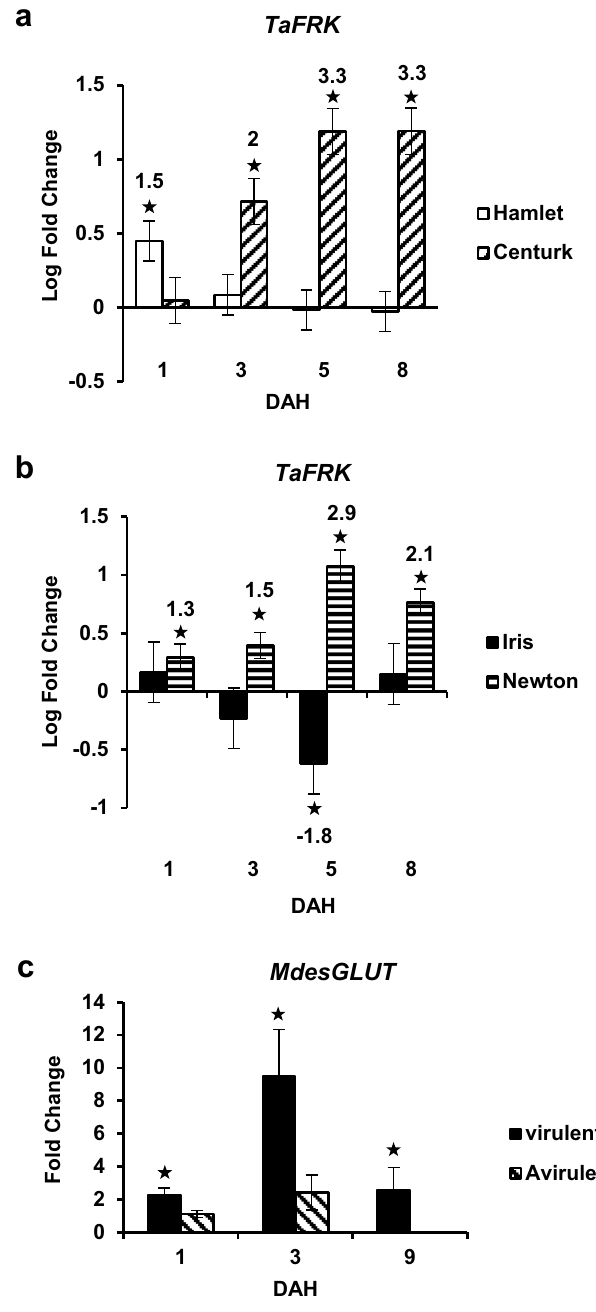
Figure 6. Expression of monosaccharide metabolism/transport genes in wheat and Hessian fly larvae. Transcript levels of TaFRK in ( a ) Hamlet (resistant, white bars); Centurk (susceptible; diagonal bars) and ( b ) Iris (resistant, black bars); Newton (susceptible; parallel bars) wheat lines at 1, 3, 5 and 8 DAH. Values are the logarithmic fold change ± SE of transcript levels in infested wheat samples as compared to the uninfested control at respective time points. Significant fold change values are shown on top of each bar. ( c ), Transcript levels of MdesGLUT in virulent (1, 3 and 9 DAH) and avirulent (1 and 3 DAH) Biotype L Hessian fly larvae feeding on susceptible (Newton) and resistant (Iris) wheat plants, respectively. Values are the fold change ± SE of transcript levels in virulent (black bars) and avirulent (diagonal bars) larvae as compared to neonate larvae (collected on the day of egg hatch). Error bars in all graphs represent data from three biological replicates ( n = 3; each with three technical replicates). Statistically significant ( p < 0.05) differences are indicated by